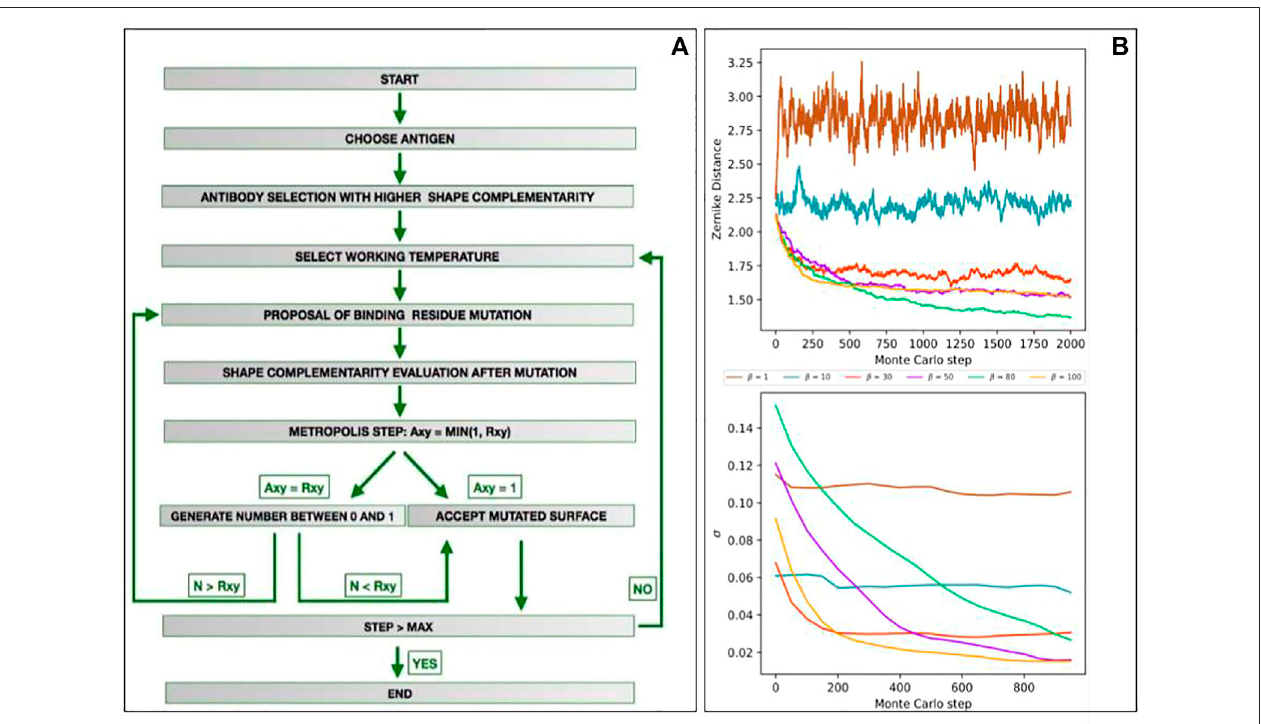
FIGURE2| DevelopmentofaMonteCarlosimulationforshapecomplementarityoptimizationagainstatargetregion. (A) Flowchartdepictingthemainstepsofthe computational protocol we developed. (B) Results of the mutagenesis Monte Carlo procedures performed at fi xed β ( β = 1, 10, 30, 50, 80, and 100). The top panels representtheenergy(i.e.,theshapecomplementarity)asafunctionoftheMonteCarlosteps.Thelowpanelsshowthestandarddeviationofenergyoftheremainingpart of the Monte Carlo simulations as a function of the Monte Carlo steps (i.e., σ ( E ) for n = 1,000 means standard deviations of the energy obtained in the steps 1,001 – 2,000).